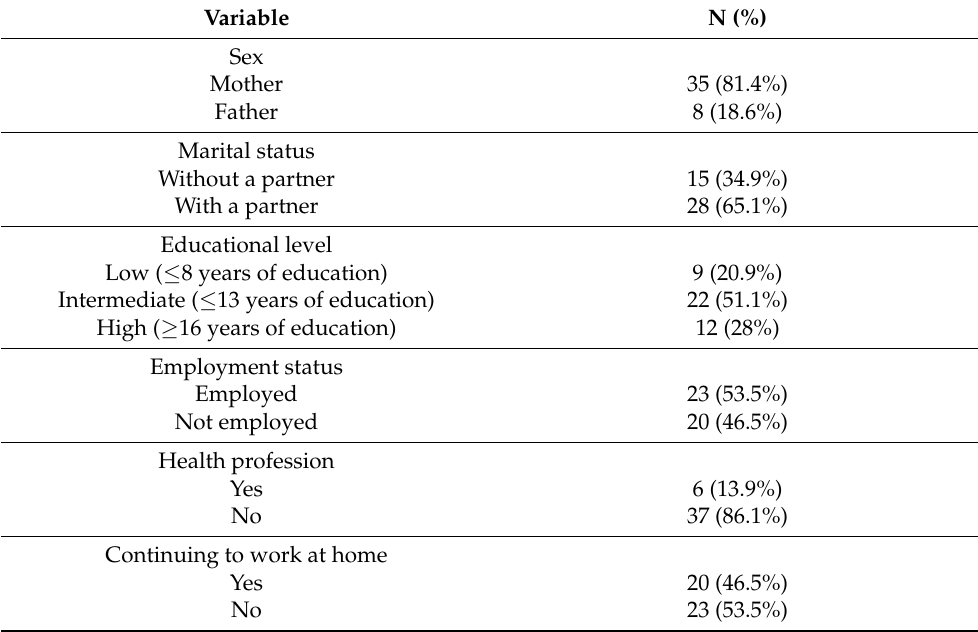
Table 2. Parental